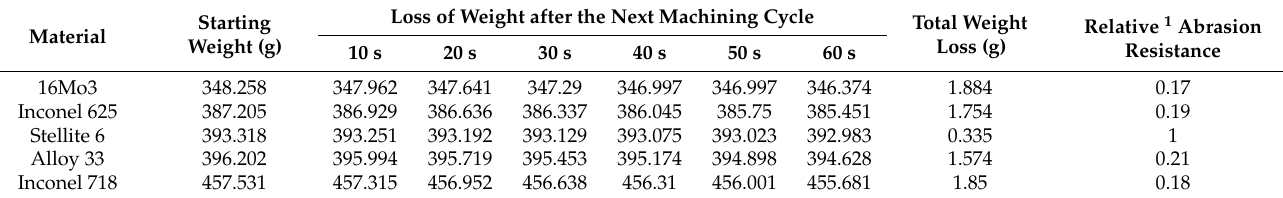
Table 6. Results of abrasive blasting wear test.